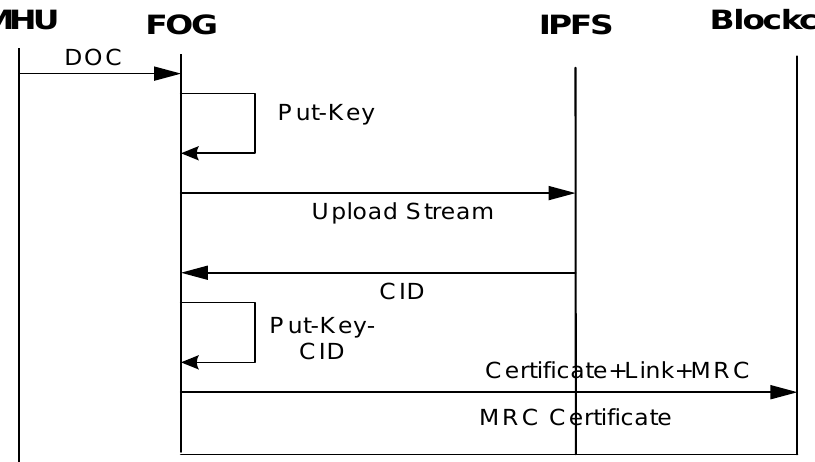
Figure 8. Sequence diagram of the proposed